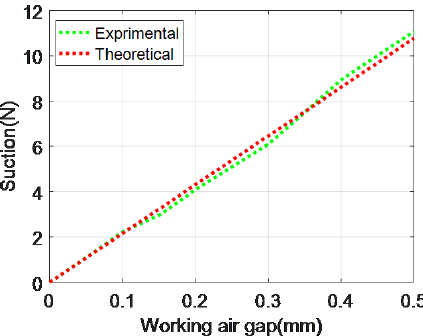
Figure 14. Stiffness curves of leaf spring for theoretical and exper- imental results.